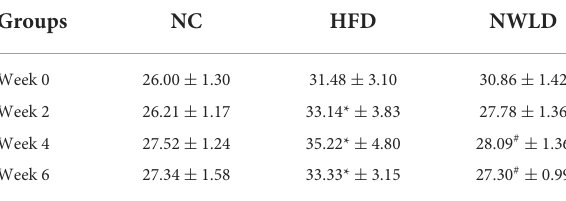
TABLE 2 Body weight (g) changes of mice fed with different diets (mean ± SD).